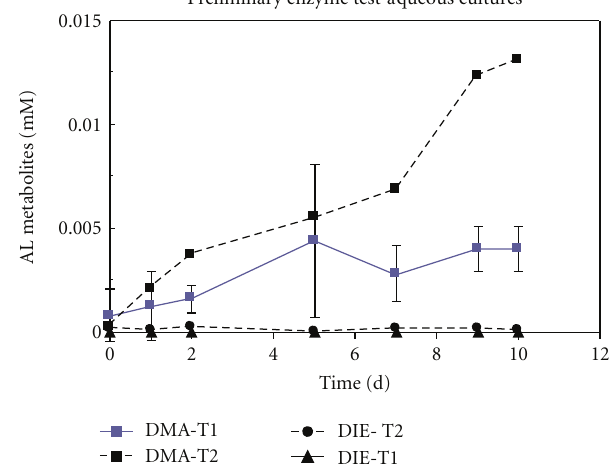
Figure 3: Production of alachlor metabolites during preliminary enzyme test in aqueous cultures. Treatment 1 consisted of the EES only and Treatment 2 consisted of the EES and H 2 O 2 . DMA = 2- chloro-2 (cid:2) ,6 (cid:2) -diethylacetamilide, DIE = 2,6-diethylanaline. Cumulative CO 2 evolution EES degradation study